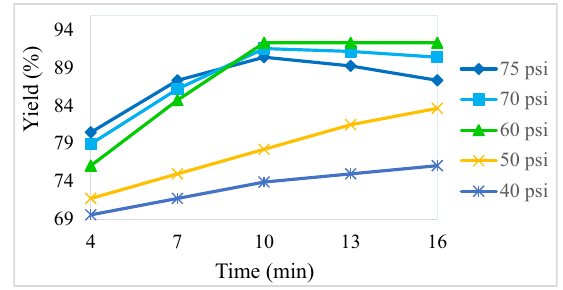
Figure 3: E ff ect of inlet pressure on the CES yield in surveying time of 4 – 16 min.